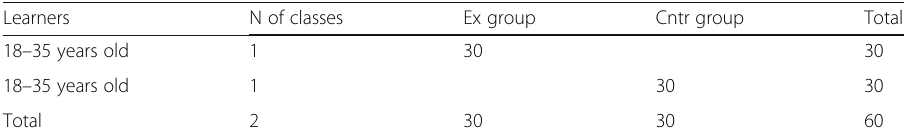
Table 2 Demographic information about the subjects ( N = numbers) Learners N of classes Ex group Cntr